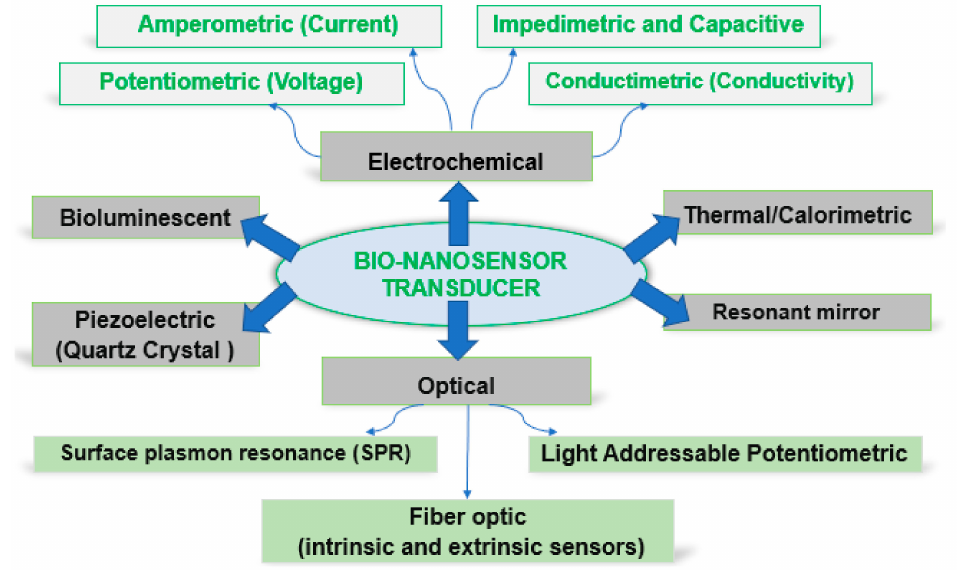
Figure 4. Schematic representation of biosensor